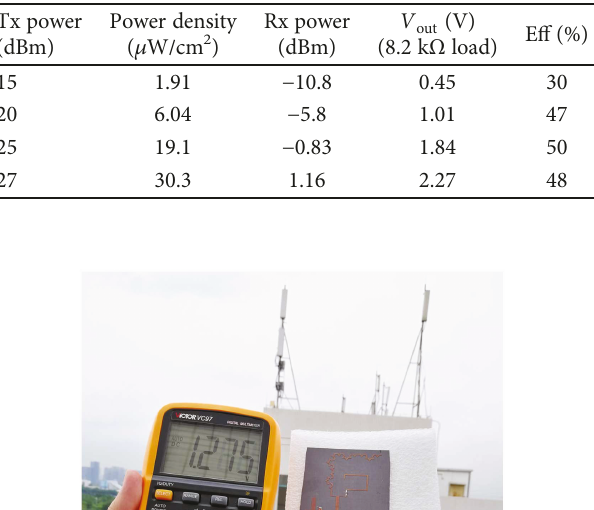
Table 3: Comparison with recently reported rectennas. Ref.